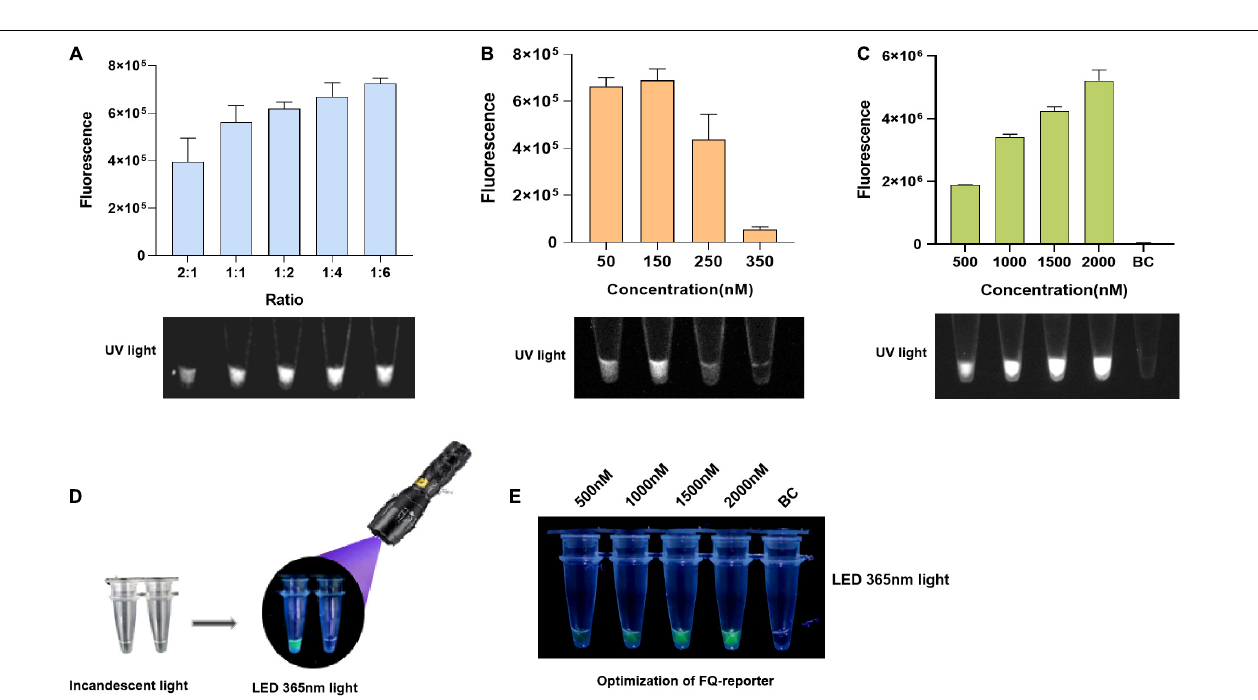
FIGURE 2 | Establishment of the RPA/Cas12a-fluorescence assay. (A) End point of Cas12a-fluorescence assay at different LbCas12a/crRNA ratios. (B) Optimization of LbCas12a concentration. (C) Optimization of FQ-reporter concentration. (D) Visualization with a mini-UV torch. (E) Optimized visualization results of FQ-reporter with a mini-UV torch. The UV light images were taken by the gel imaging analysis system.